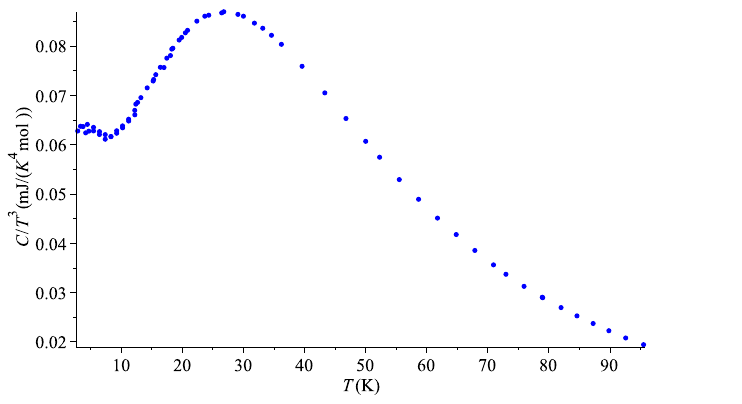
Figure 9. Specific heat of sodium chloride, data of Ref. 54 as presented in Ref. 53